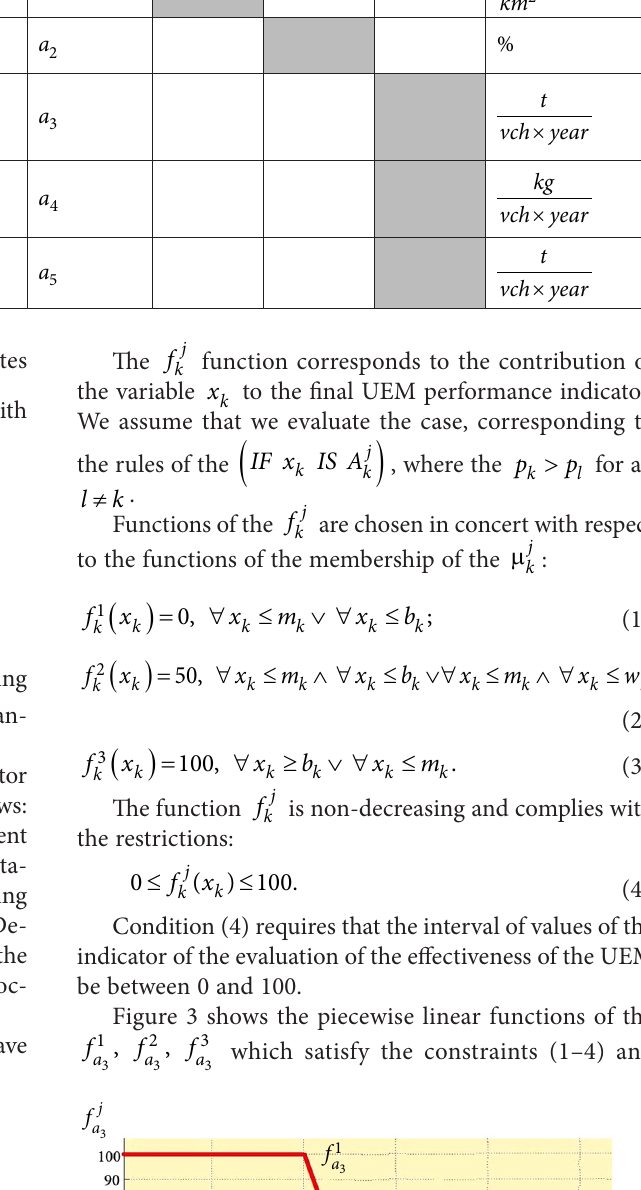
Table 1. A fragment of the primary indicators of the material and energy flows of the urban environment (this is an example of the transport subsystem) Primary indicators of the material-energy flows of the urban environment